Question: Name the type of graph shown.
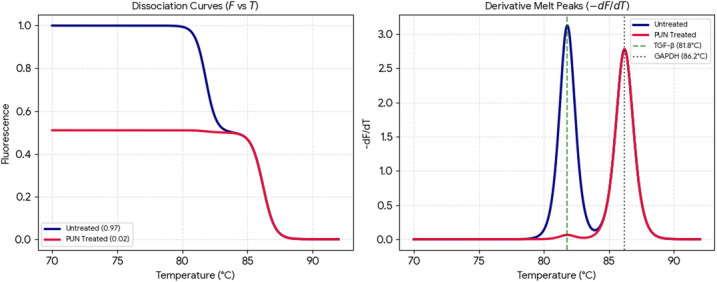
Answer: line